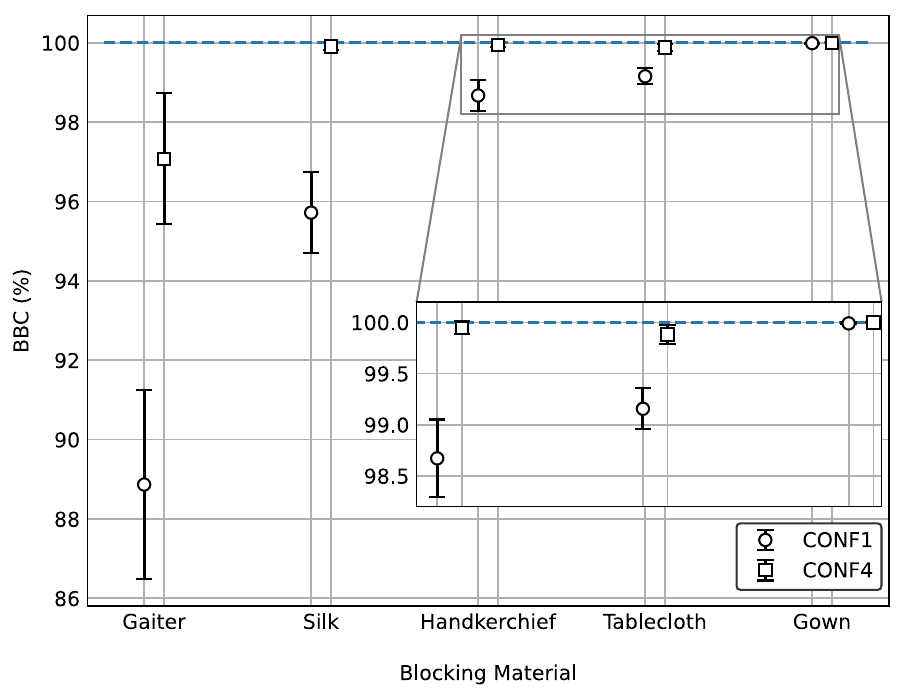
Fig 5. Source control vs. wearer protection. BBC for different mask materials in CONF1 (circles) vs CONF4 (squares). Inset: zoom near BBC = 100%. A target is better protected by a mask wore by the source than by a mask wore by her/himself.